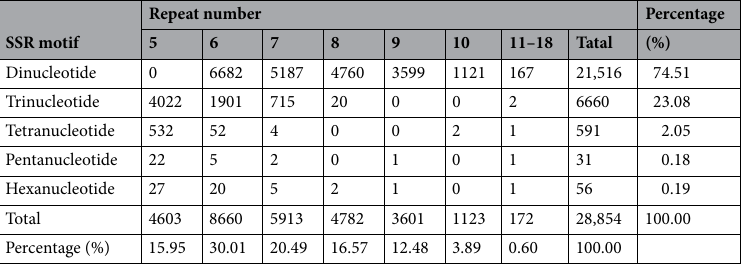
Table 1. Frequencies of different SSR repeat motif types observed in the C. japonica leaf